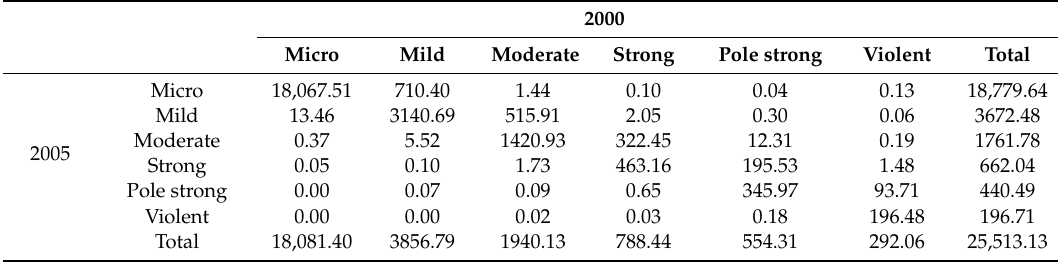
Table 5. The transfer matrix of soil erosion intensity grades in the Taohe River Basin from 2000 to 2005 (km 2 ).